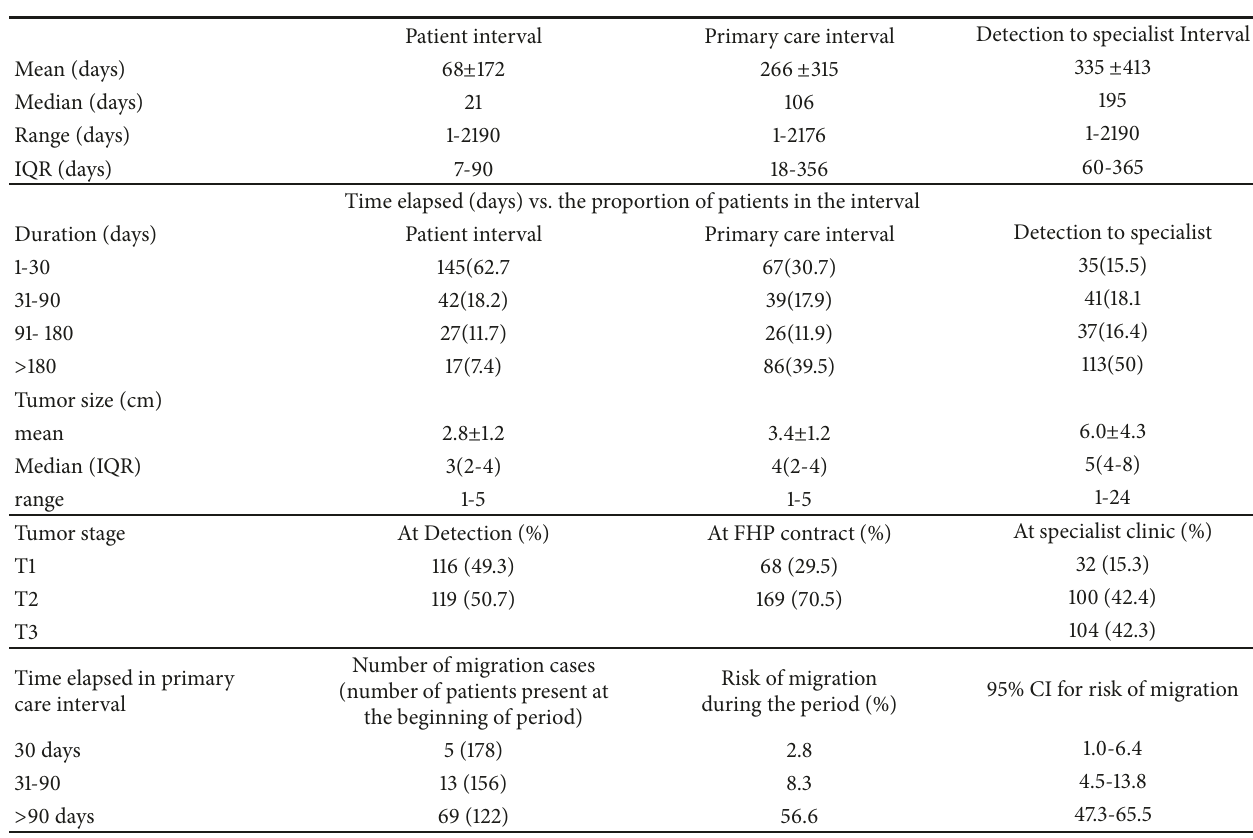
Table 2: Distribution of interval lengths and risk of tumor size migration: The mean and median of the primary care interval were longer than the patient interval. Risk of stage migration increased as the patient stayed longer in the primary care